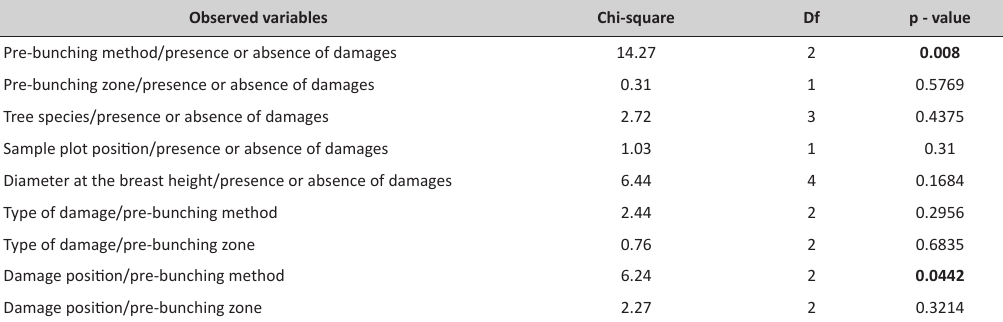
TAbLe 2. Chi-square test parameters.